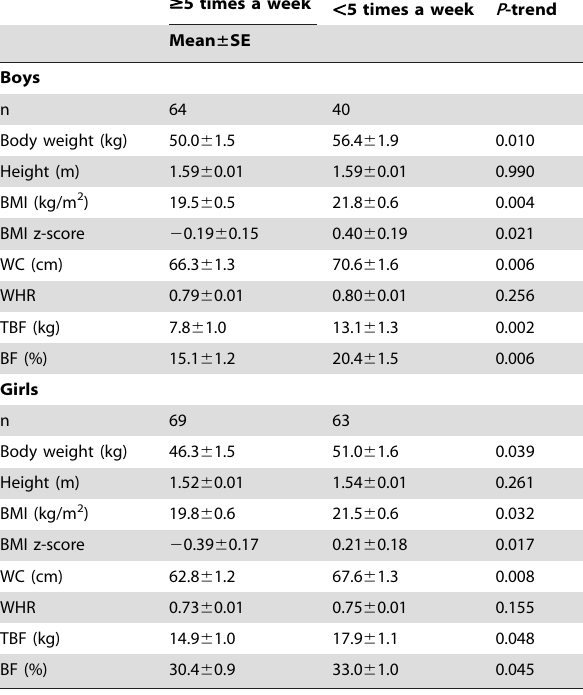
Table 3. Gender-specific multivariate analysis of the relationships between breakfast consumption status and body composition profiles in male and female adolescents 1